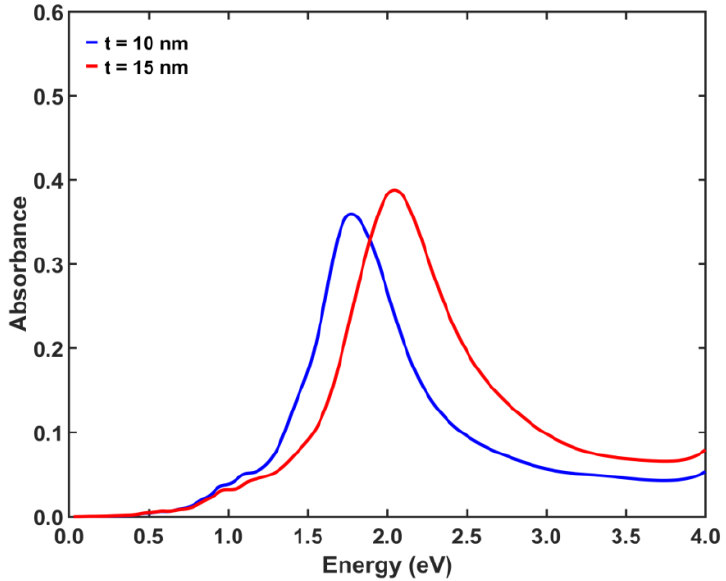
Figure 10. The absorbance spectrum of 85 at.% Ag and 15 at.%Pd, with reduced t values, when d = 100 nm and a = 200 nm.